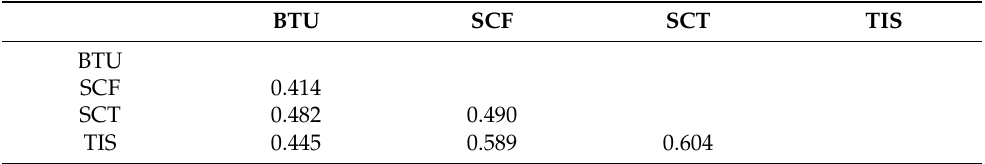
Table 4. Discriminant validity (heterotrait–monotrait ratio).